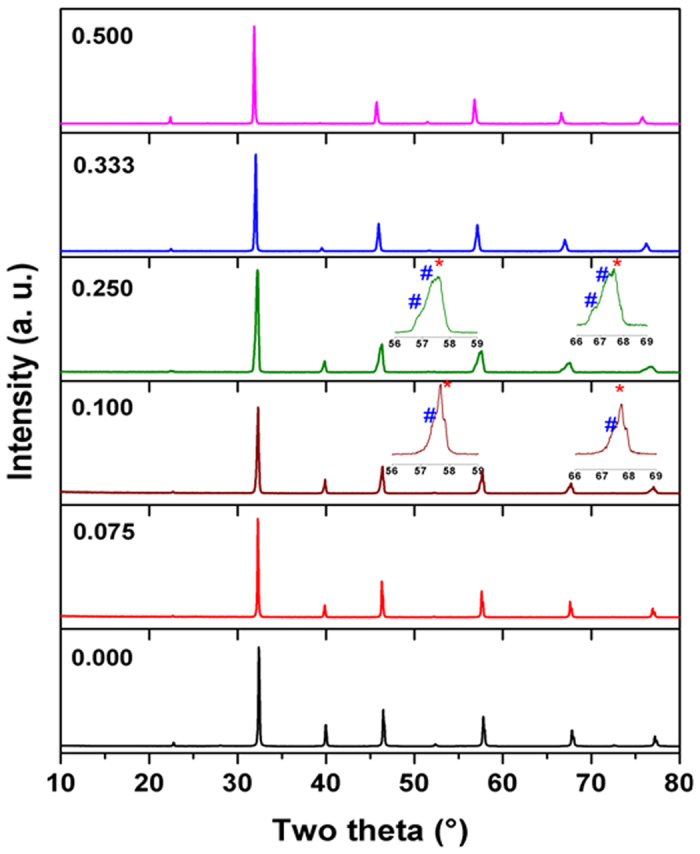
Powder XRD pattern of SrTi1−2xFexTaxO3 compositions.(# & * indicate orthorhombic and cubic phases, respectively).